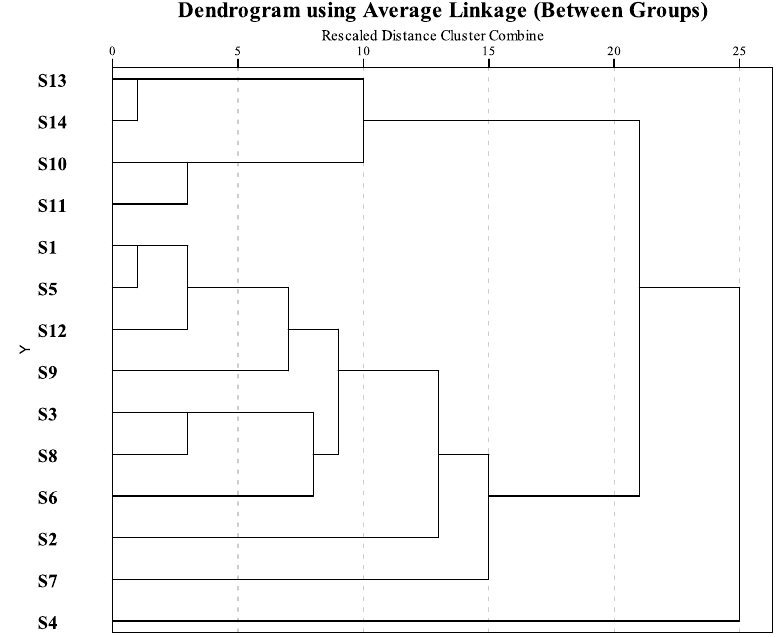
Figure 5. Dendrogram of the hierarchical cluster analysis of 14 samples based on the relative content of terpenoid compounds. The abscissa denotes the Euclidean distances and the ordinate denotes the sample numbers, which are the same as in Table 2.